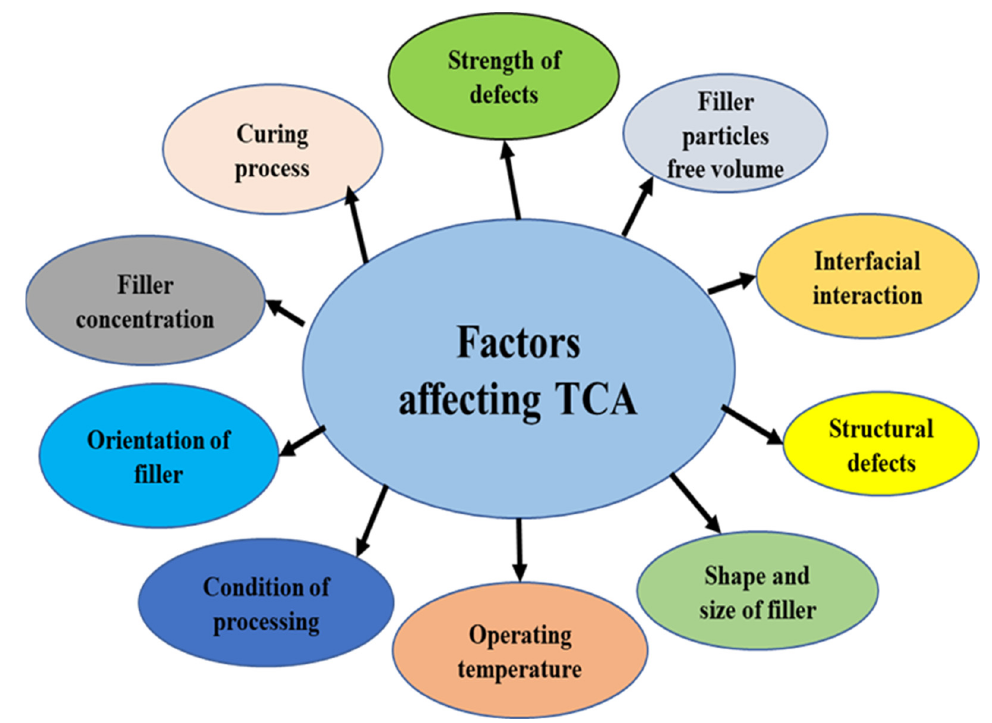
Figure 12. Common factors that can affect a